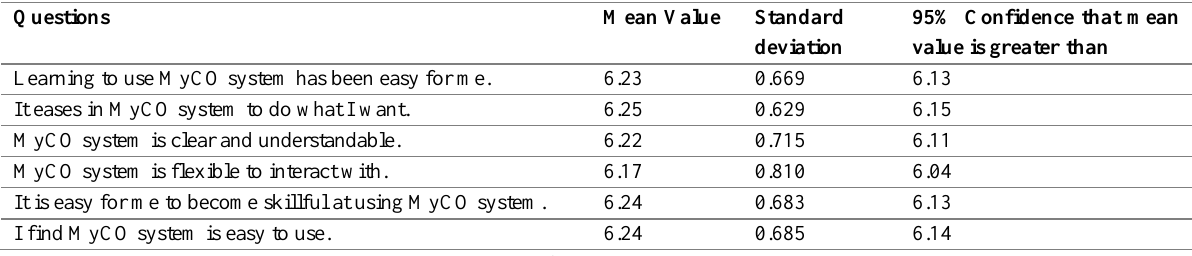
Table 4: Results of questionnaire processing related to perceived ease of use of MyCO system Questions Mean Value Standard 95% Confidence that mean